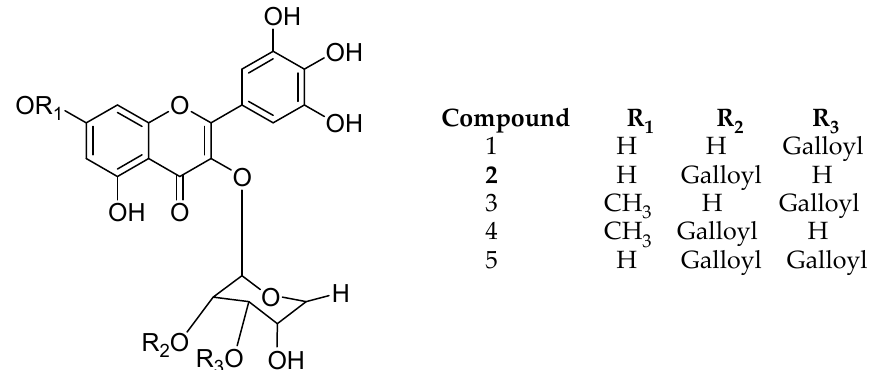
Figure 9. Structure description of myricetin galloylglycosides.